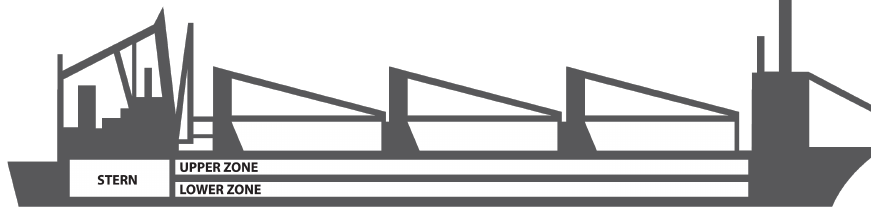
Figure 7. Base Ship